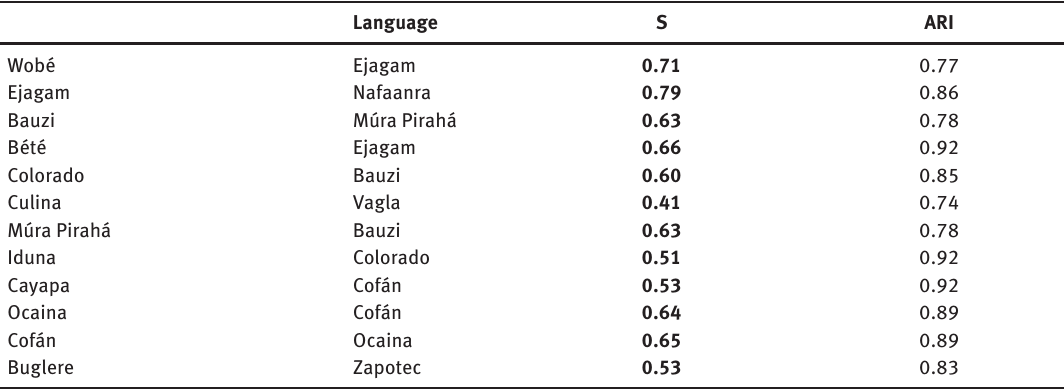
Table 3: Most similar languages in the WCS corpus for languages figuring in Table 2. Language S ARI Wobé Ejagam